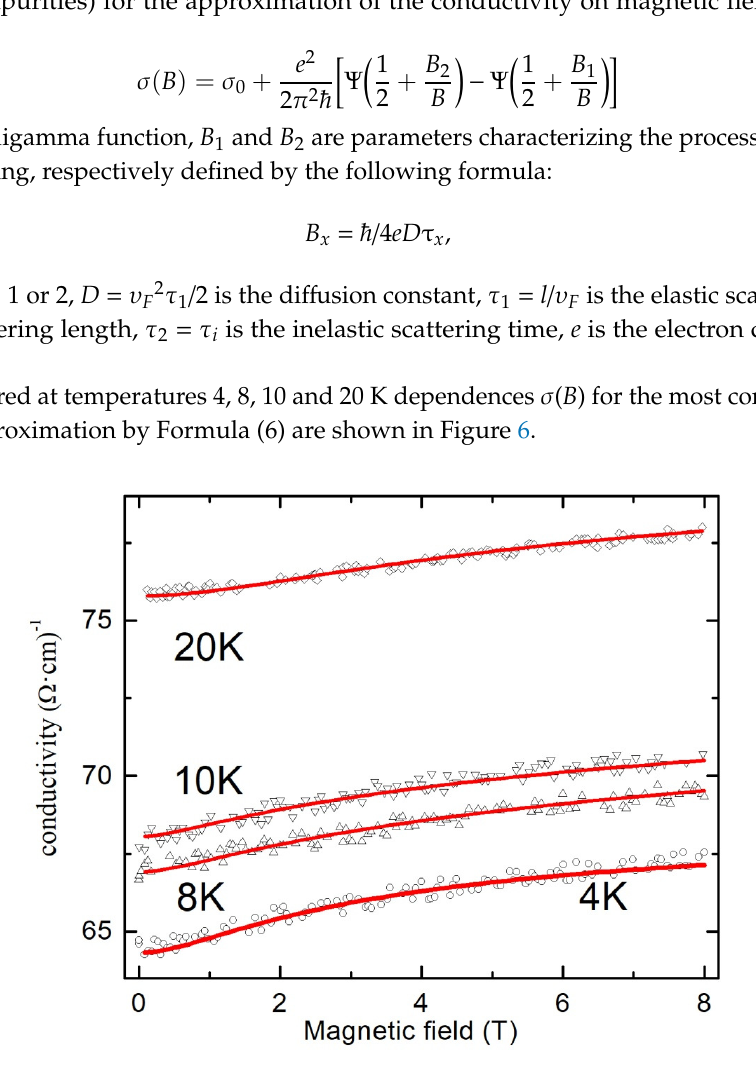
Figure 6. Magnetoconductivity at various temperatures of polycrystalline SnO 2 − δ film (sample B). Solid lines are fits by Formula (6).